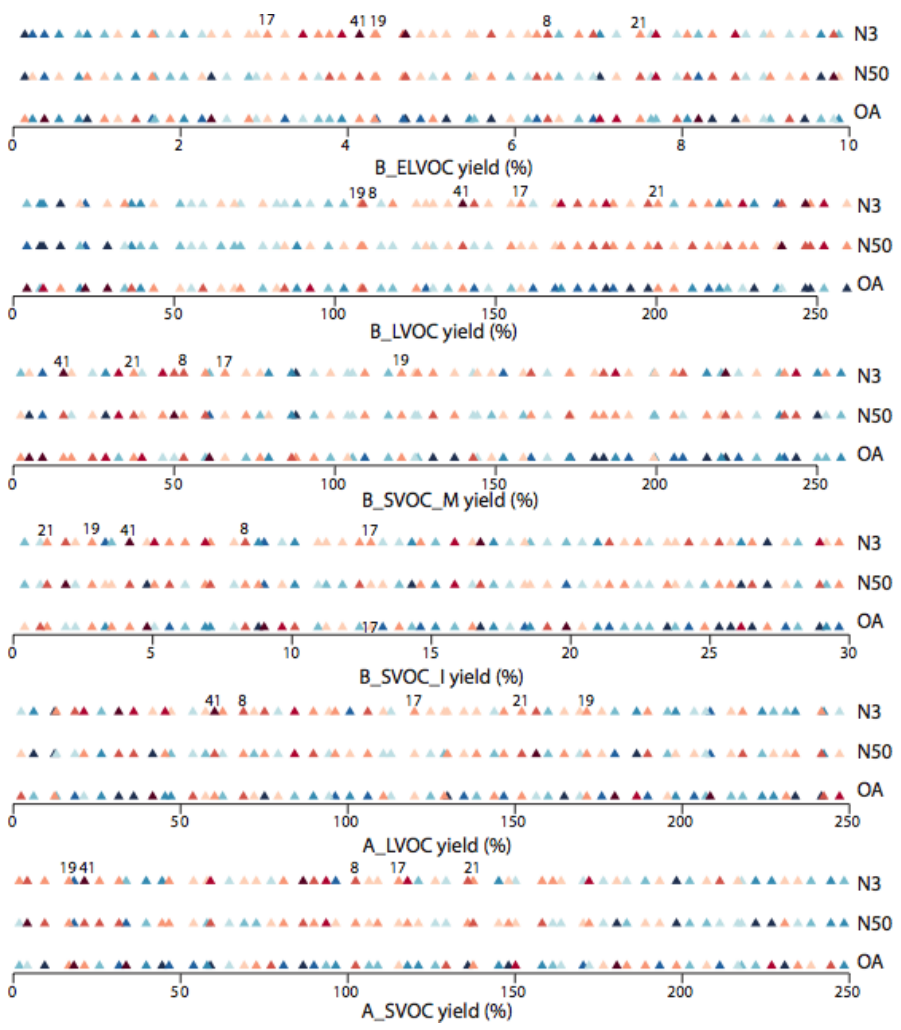
Figure 13. The 1-D representation of the 6-D space-filling design of experiments shaded by model performance. The 18 subplots (labelled in plot) correspond to the design of experiments for six ox-VOCs, each shaded according to the Taylor skill score (TSS) in three model outputs (N3, N50, OA – in that order for each ox-VOC). Each subplot shows the parameter range perturbed for the yield (%) of the corresponding ox-VOC* ( x axis). Each point on a subplot represents a simulation, and the colour of the point indicates the performance of the simulation (TSS) against observed N3, N50, or OA. Darker shades of blue indicate low/poor TSS and darker shades of red represent high/good TSS. The plot identifies plausible and implausible parameter space for each ox-VOC. Simulations 8, 17, 19, 21, and 41 that are shaded red for all three model outputs across the parameter space of all six ox-VOCs are labelled. Note the axis for B_ELVOC shows the scaling factor for B_ELVOC yields. Axes for the rest show the corresponding ox-VOC